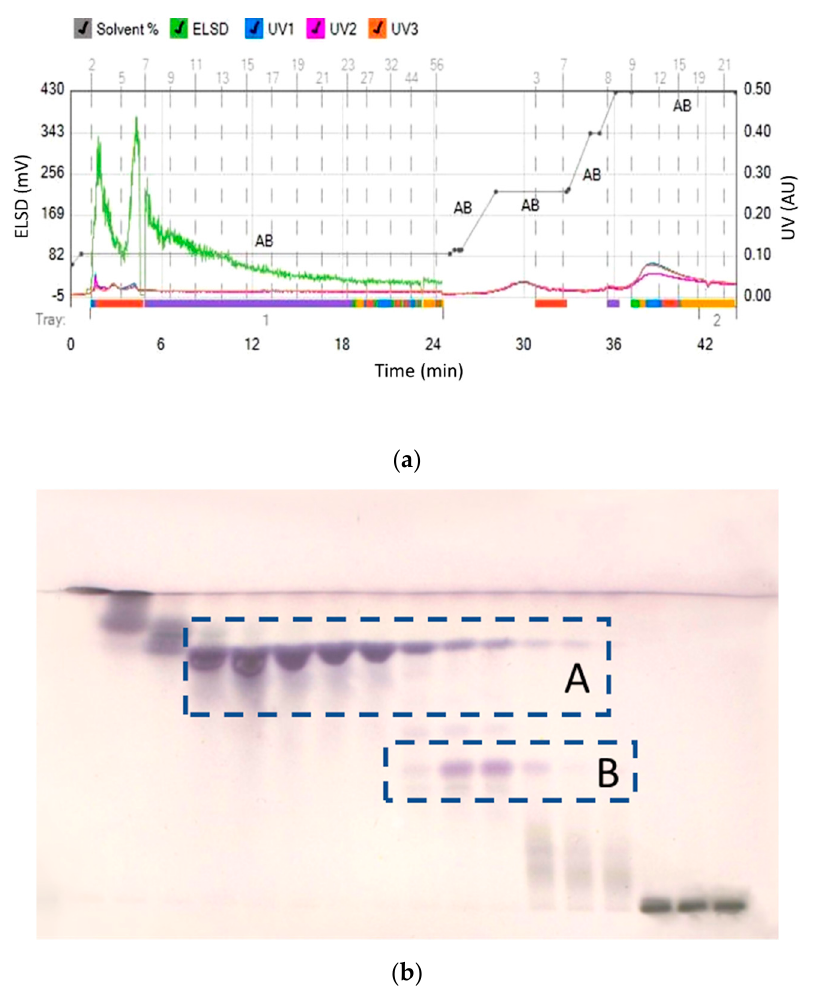
Figure 2. ( a ) Separation of combined methanol and ethanol extracts and ( b ) HPTLC assessment of collected fractions (A – oleanolic acid and B – maslinic acid).